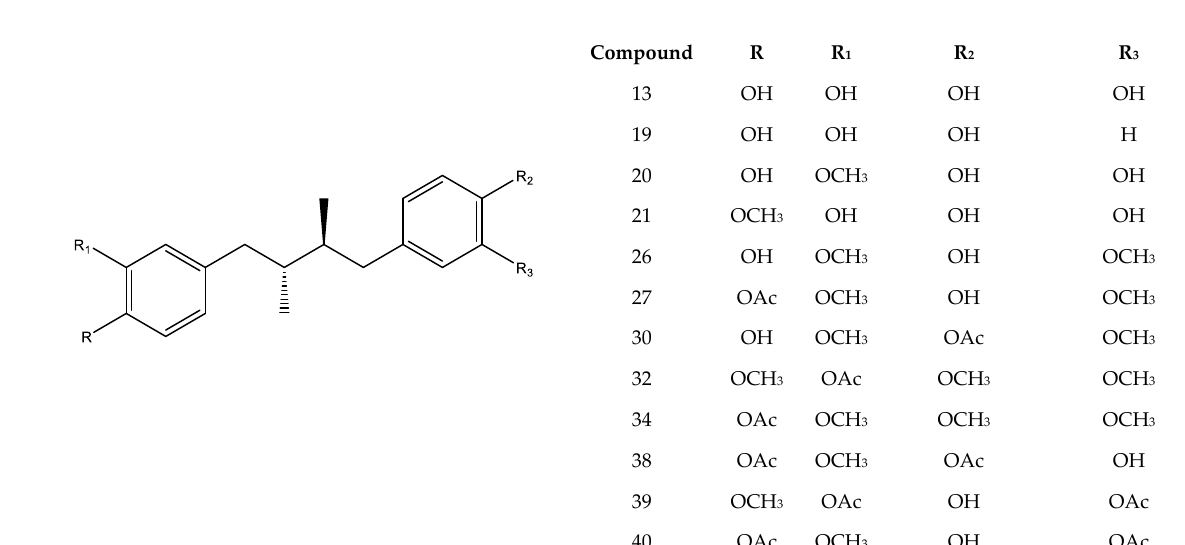
Figure 2. Flavonoids, epoxylignans and cyclolignans characterized in LnRe and LdRe resins.